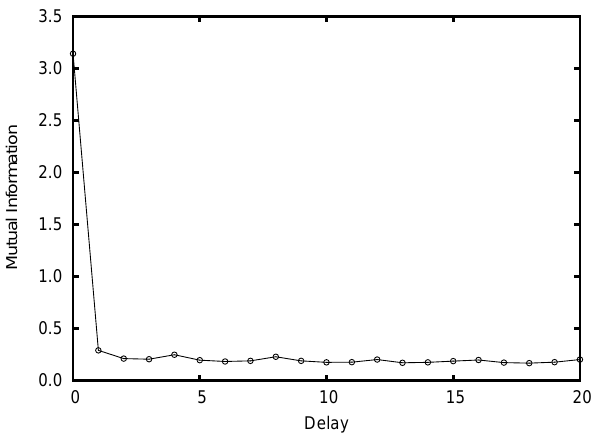
Fig. 7. The fraction of false nearest neighbours as a function of the embedding dimension m for the detrended time series with τ = 1 ,ω = 25, showing that any m ≥ 13 can be considered